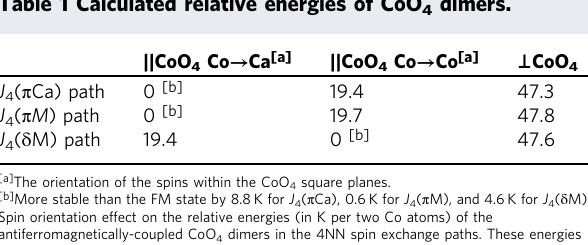
Table 1 Calculated relative energies of CoO 4